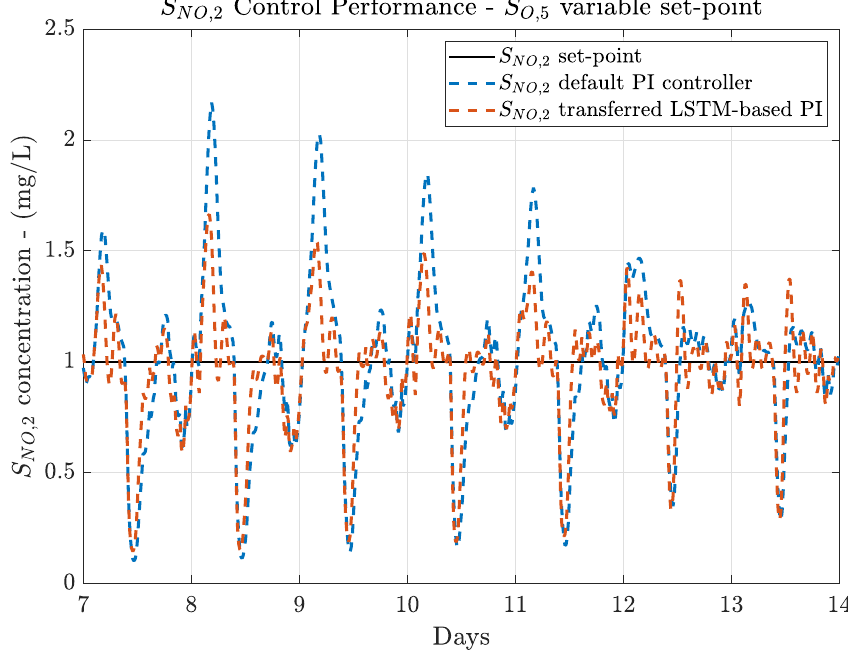
Figure 7. Control performance for the NO control loop when the LSTM-based PI derived from the DO control loop is transferred into